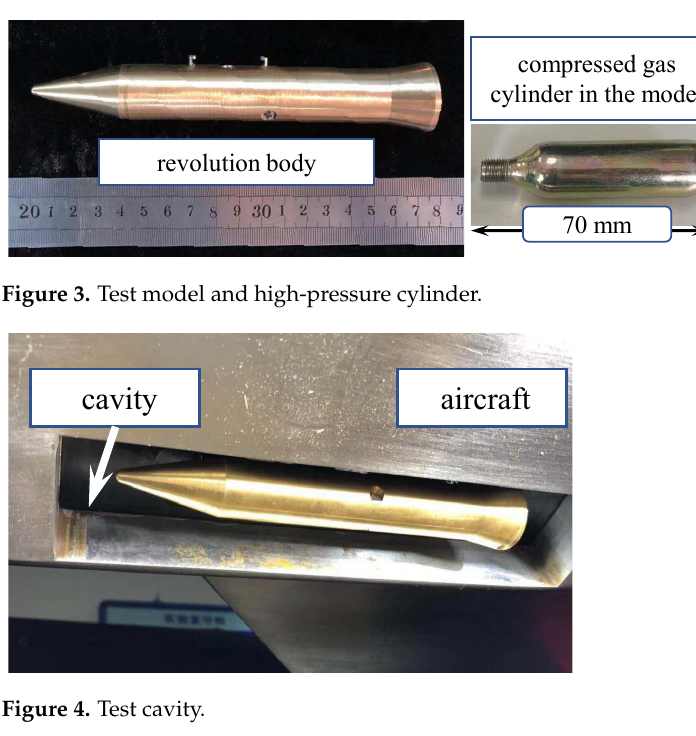
Figure 4. Test cavity.